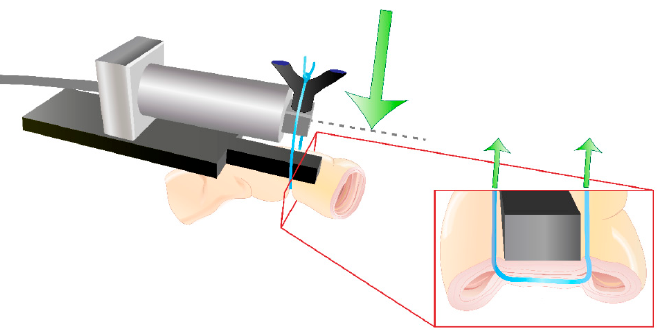
Figure 10. Visualization of the custom modified suture tension load cell for the in vivo tension measurements in rabbits. Green arrows indicate the measured suture tension forces.